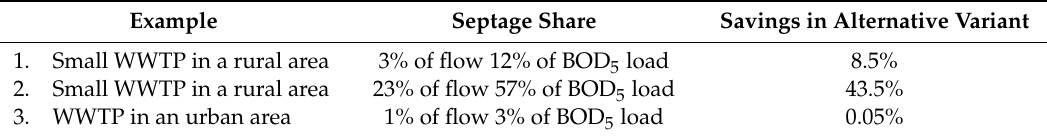
Table 4. Comparison of optimization model